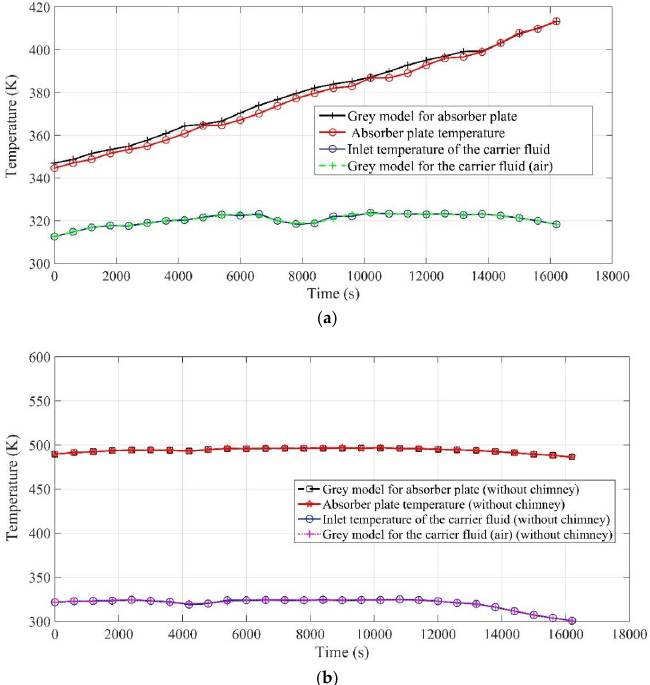
Figure 9. Temperature distribution for solar air heater: ( a ) chimney, ( b ) without chimney. Relatively, the kurtosis of the numerical solution is increased by 1.086%. The nature of the distribution pattern is leptokurtic. To investigate the model in more detail, the error analysis is performed to determine whether the solution estimated through the linear grey model is feasible or not. The mean absolute percentage error (MAPE(T)) estimated while predicting the temperature of the absorber plate and inlet temperature of the carrier is shown in Figure 10. The maximum MAPE(T) for the linear grey model was 0.037% while comparing the instrumental data of the absorber plate, whereas the lowest possible MAPE(T) was 3.46 × 10 −4 % during the time interval of 14,000–16,000 s. When the generated solutions were compared, the maximum value of MAPE(T) dropped by 85.18% for the numerical solution derived for the conventional system. The lowest possible MAPE(T) was also reduced by a margin of 51.64%. Similarly, for the carrier fluid (air), the MAPE(T) has a maximum value of 9.97 × 10 −3 % for the non-conventional system, which is 39.72% lower than the MAPE(T) value evalu- ated for the conventional system. So, it could be seen that the linear grey model is suitable to predict the temperature distribution of air at the inlet of the solar air heater, whereas in the case of forecasting the absorber plate temperature, the proposed model provided a robust solution for the conventional solar air heater. The convergence of the nonlinear grey model is also better than the analytical model to forecast the velocity of air inside the collector, although it is susceptible to the duration of the experiment.